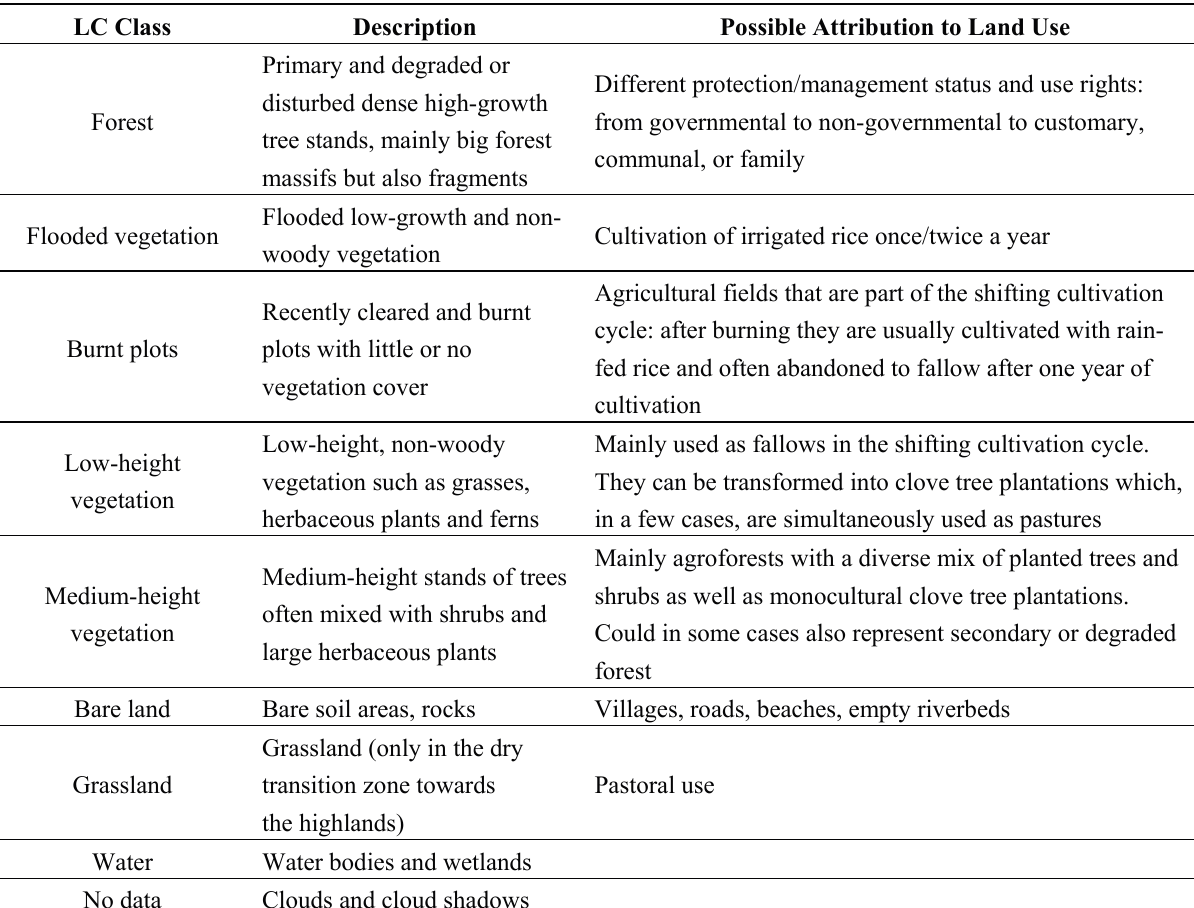
Table 2. LC classification scheme and possible attribution to land